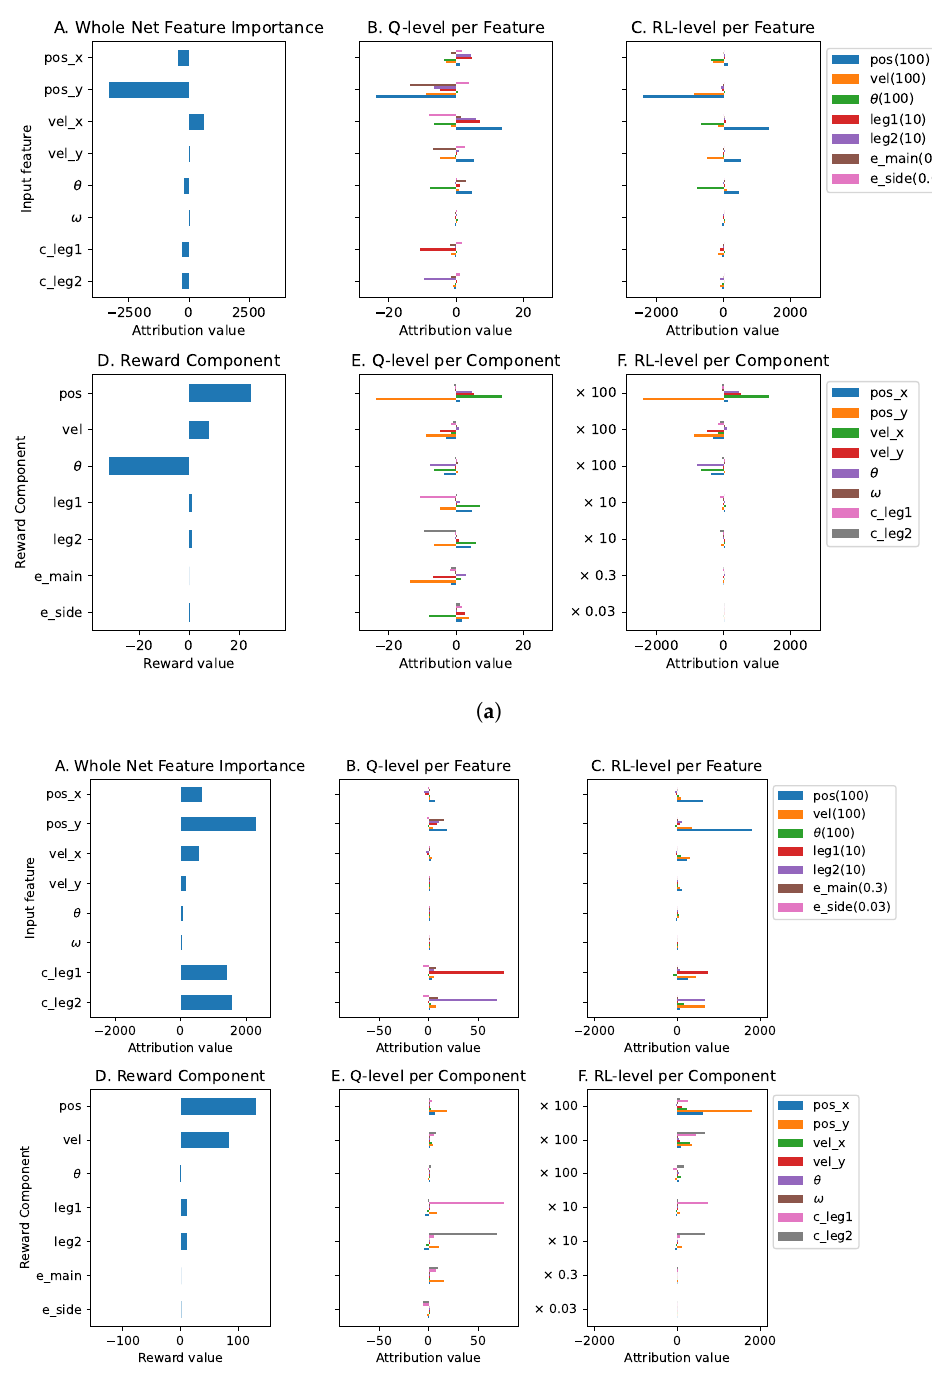
Figure A9. The local explanations of the Lunarlander of three different states as shown in Figure A6. ( a ) The local explanations of the Lunarlander when the agent chooses fire_right action on position A in Figure A6. ( b ) The local explanations of the Lunarlander when the agent chooses fire_left action on position C in Figure